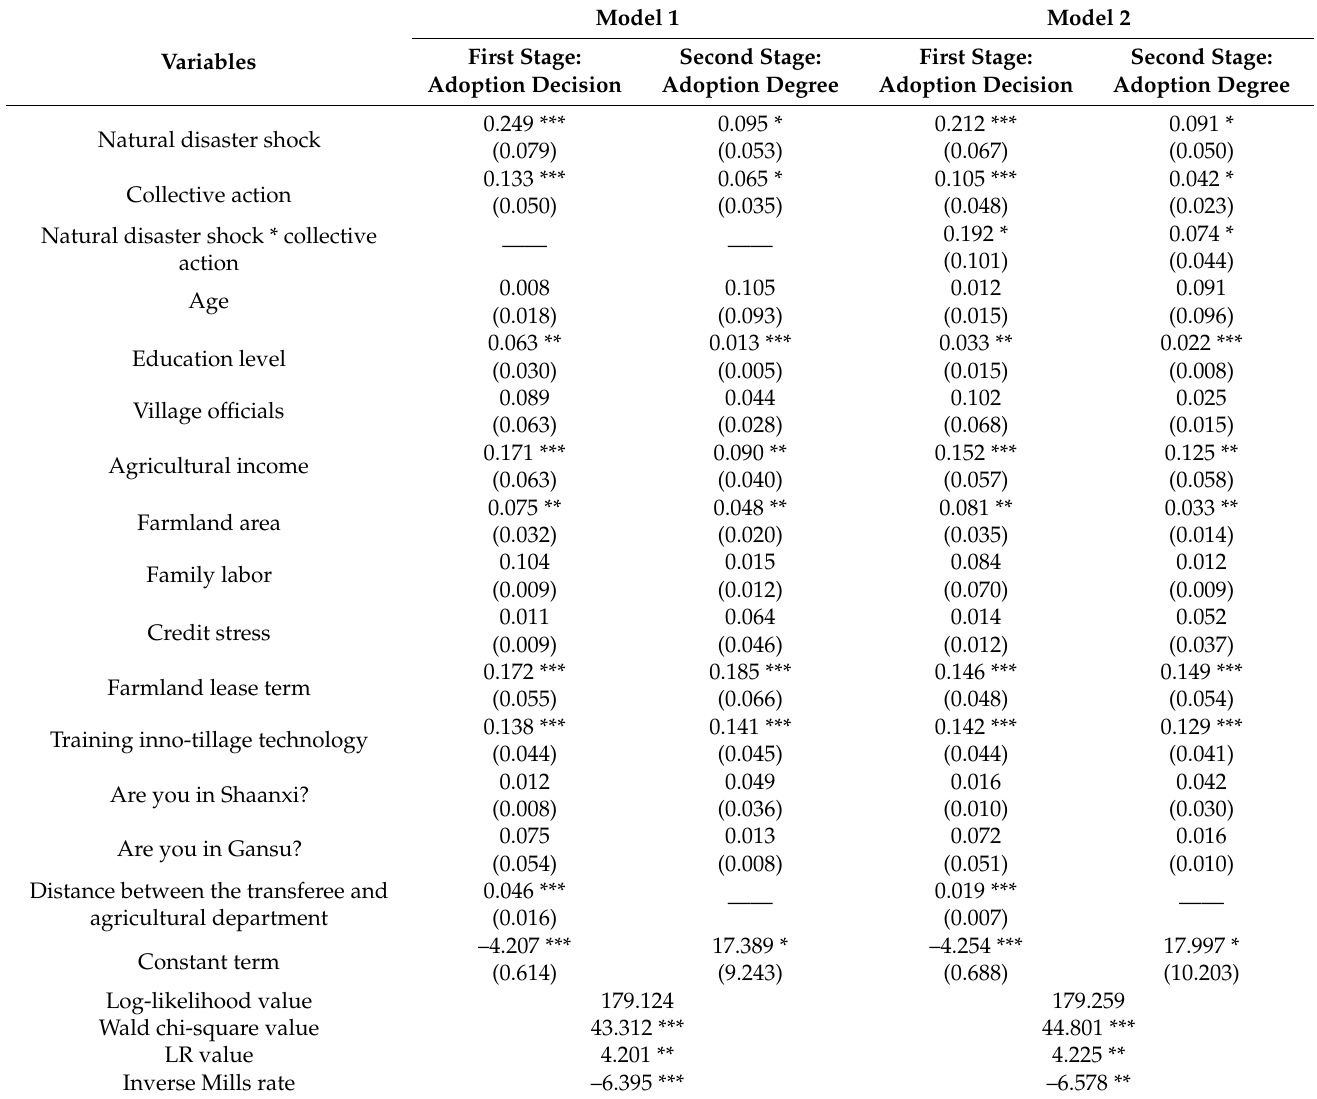
Table 6. Estimation results based on Heckman’s two-stage